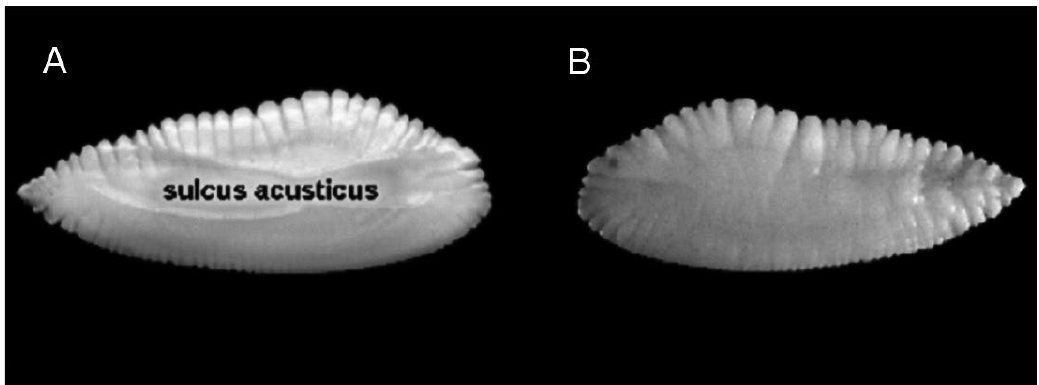
Fig. 2. – Concerning the positional normalization, the image must be from the internal side of the whole otolith. In A, the right side; the medial or internal side showing the sulcus acusticus. In B, the wrong (external) side.